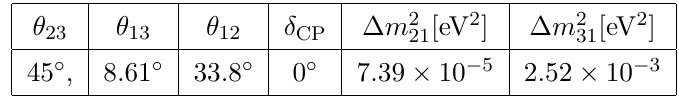
Table 2 . The values of the oscillation parameters used in our analysis. The values of the other parameters are consistent with the present best-fit values as obtained in various global fit studies [3–6]. We assume normal mass ordering (NMO) throughout the